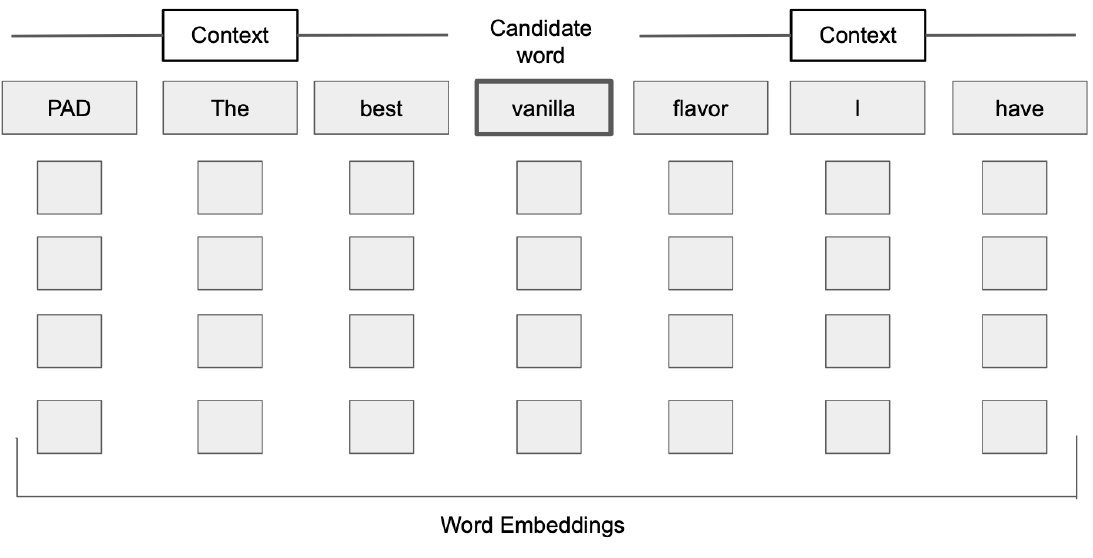
Figure 6 : Format described by the blog post for input data for training the